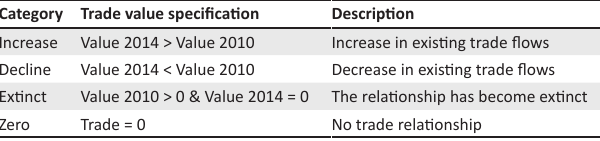
TABLE 3: Categories of utilisation.